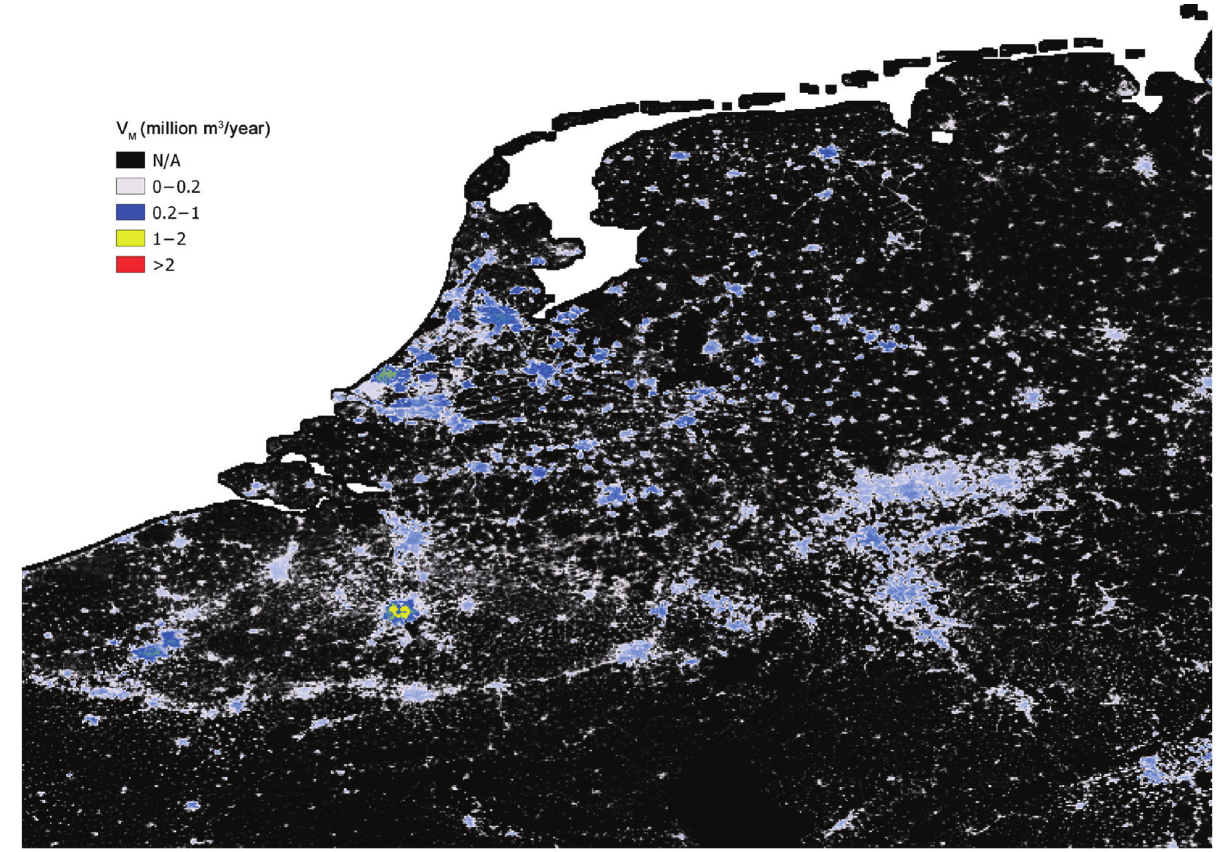
Industry water withdrawal for the year 2018) spatialised using the 2018 ( V M GHSL population density layer and the World Bank database (‘access to electricity’). This figure shows an area of the Netherlands and Northern Germany. Geographic projection. Spatial resolution 30 arc-seconds (approximately 1 km at the